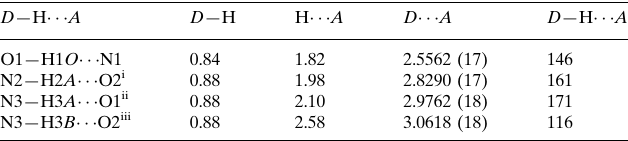
WebMOPro (Schmidt & Polik,